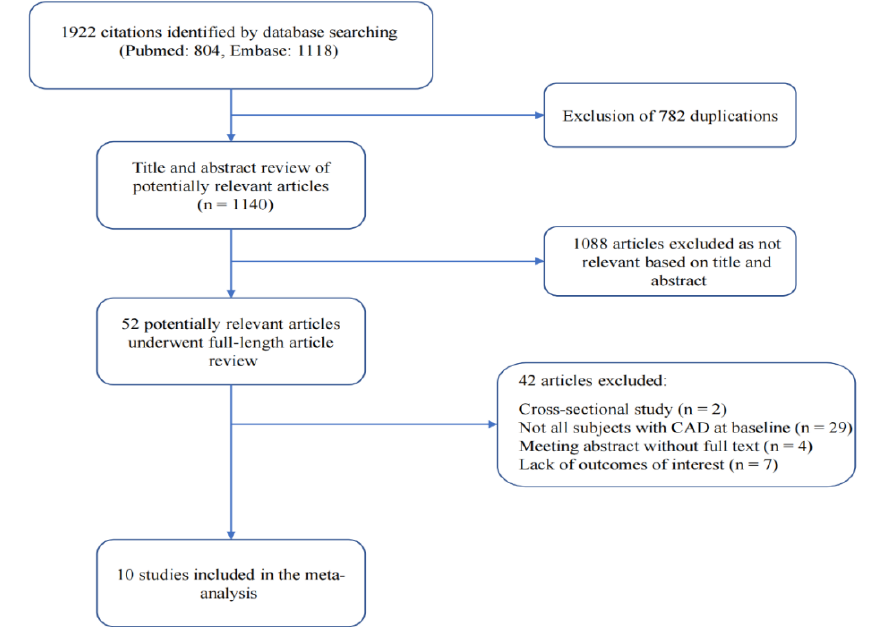
Figure 1. Flow chart of meta-analysis for exclusion/inclusion of individual articles.